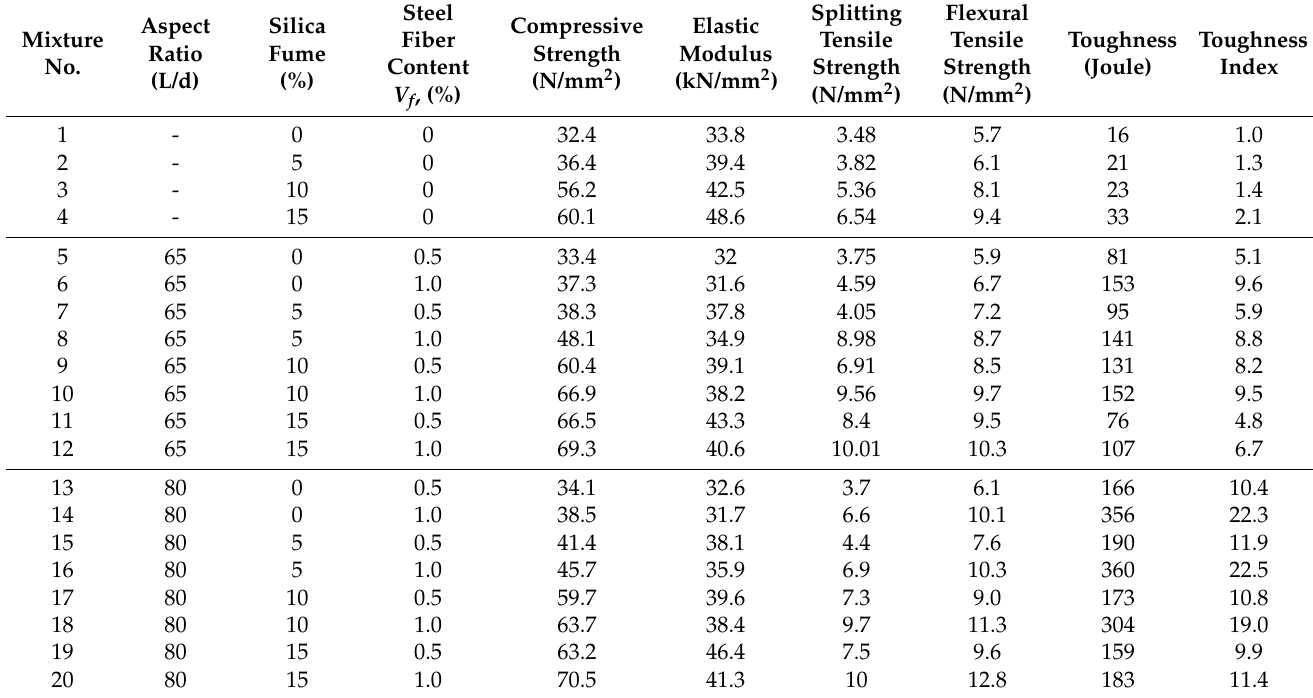
Figure 6. The relation between f st and V SF at different V f for L/d = 65.